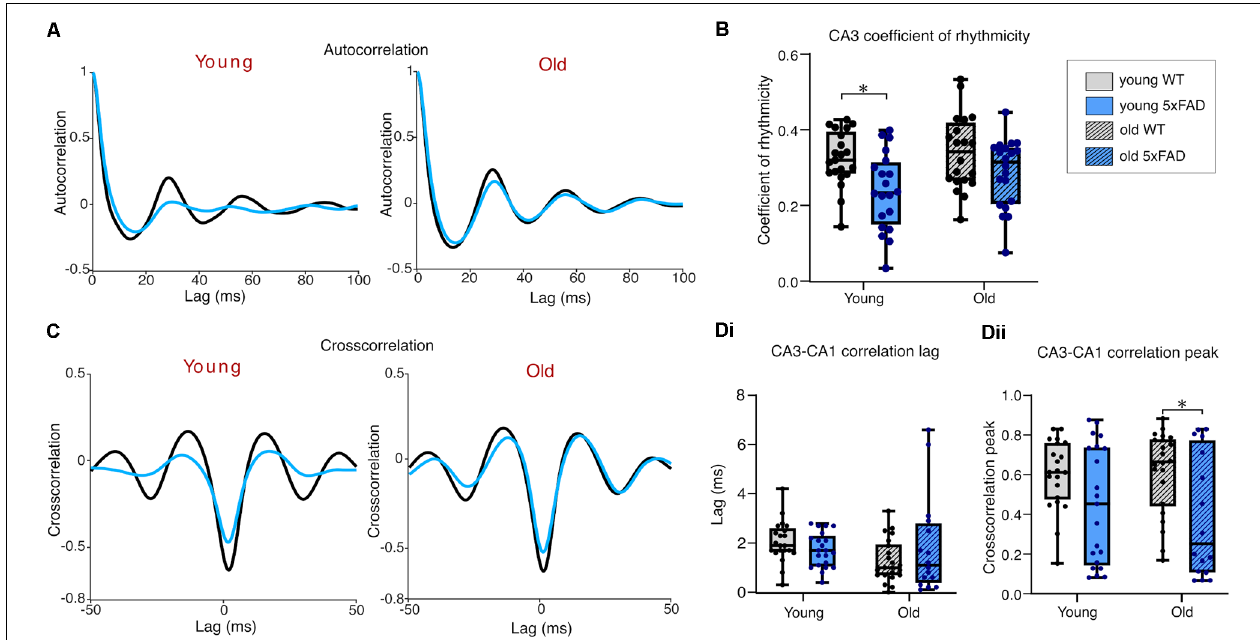
FIGURE 5 | Rhythmicity of kainate-induced gamma oscillations. (A) Mean autocorrelograms from CA3 recorded gamma oscillations. (B) Boxplots of the calculated coefficient of rhythmicity of the oscillations. (C) Mean crosscorrelograms of CA3-CA1. (D) Group data cross correlation lags (Di) and peaks (Dii) from CA3 to CA1. Young WT: n = 21/21 (A,B/C,D) , eight mice (three females); Young 5xFAD : n = 20/21 (A,B/C,D) , eight mice (four females); old WT: n = 20/22 (A,B/C,D) , eight mice (three females); old 5xFAD : n = 20/16 (A,B/C,D) , seven mice (three females). ∗ p < 0.05 (two-way ANOVA with Sˇ idák correction for multiple